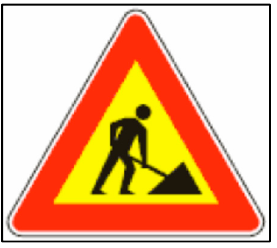
Figure 5. The traffic sign “Road works ahead” (I-19).